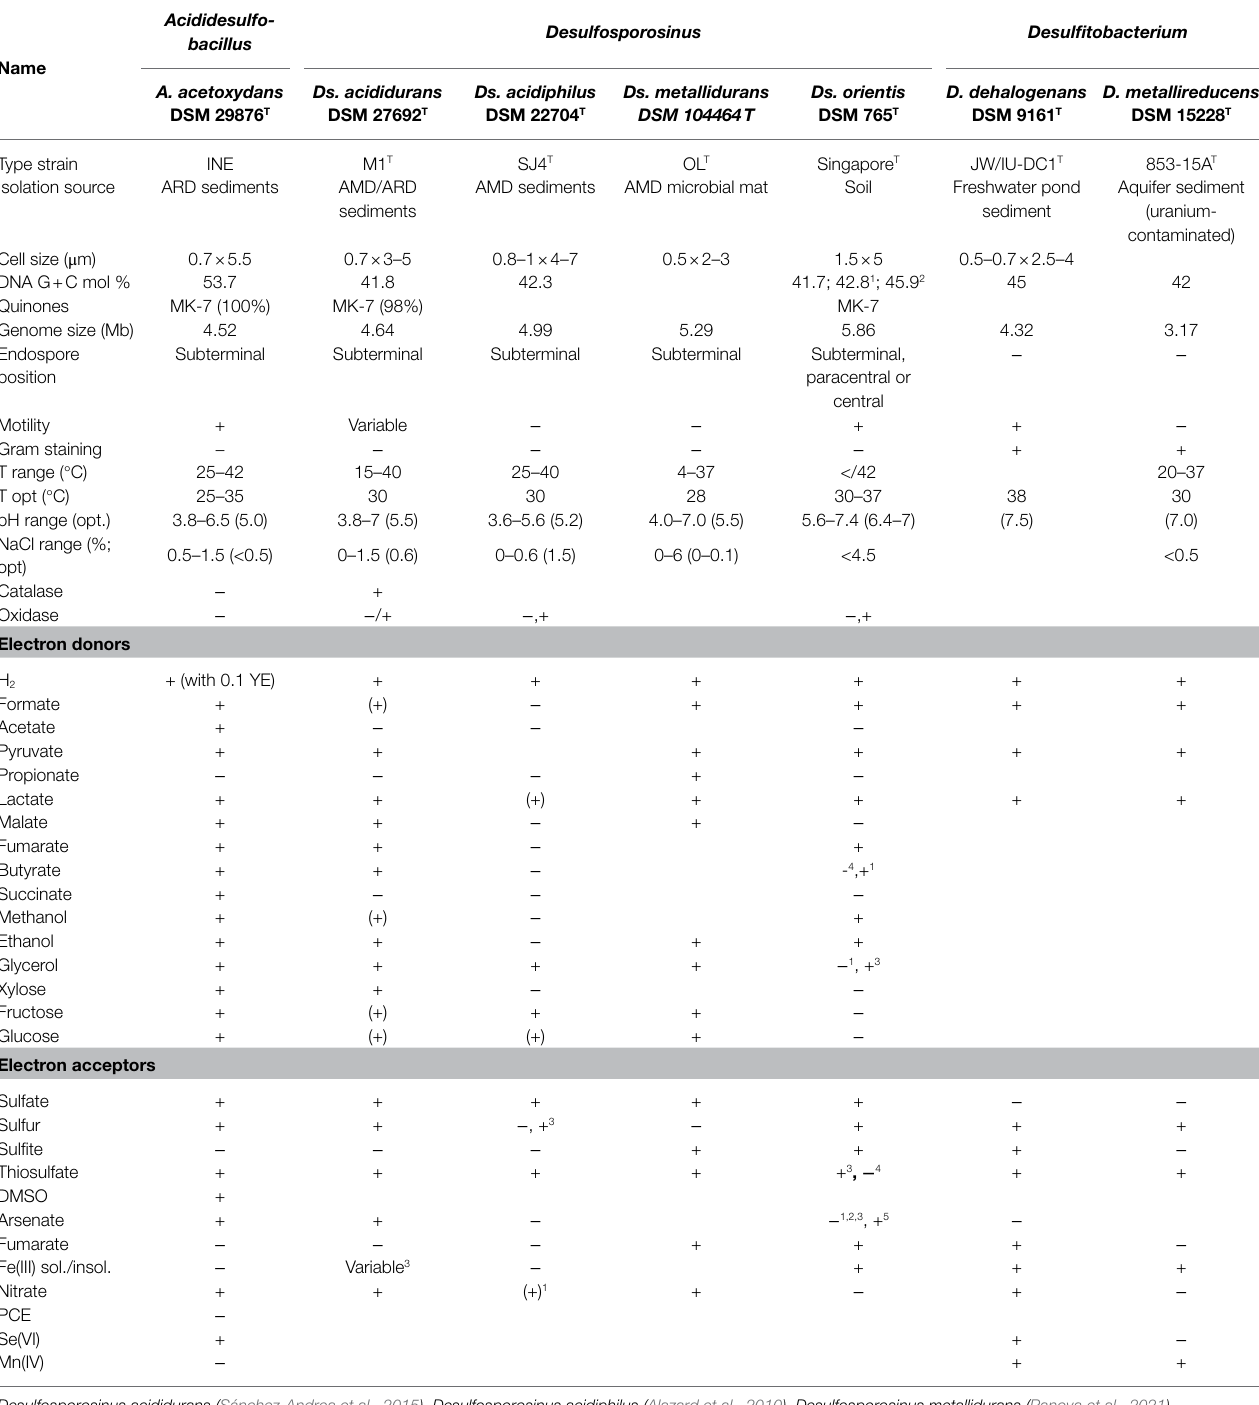
TABLE 1 | Main characteristics differentiating strain INE from its closest phylogenetic